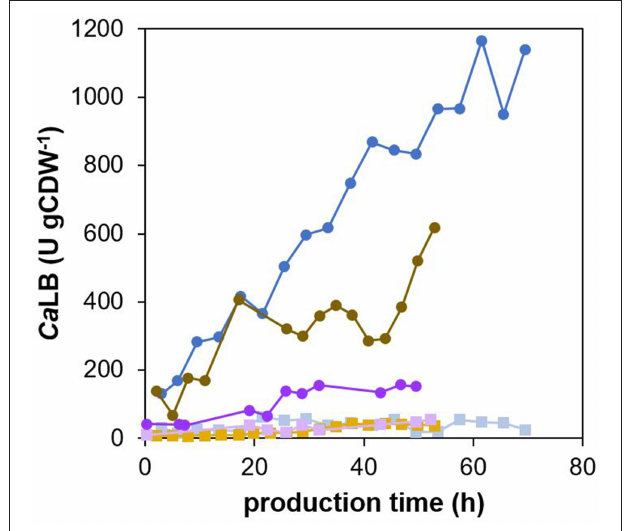
FIGURE 8 | Ca LB/biomass yield during cultivations of P. pastoris producing recombinant Ca LB under different specific growth rates with methanol. The P. pastoris strain producing Ca LB was cultured at 30 ◦ C and pH 5.5, maintaining the specific growth rate of biomass with methanol during the production phase at either 0.008 h − 1 (purple), 0.016 h − 1 (blue), or 0.032 h − 1 (brown). The secreted (dark purple/blue/brown circles) as well as the intracellular (light purple/blue/brown squares) Ca LB/biomass yield were